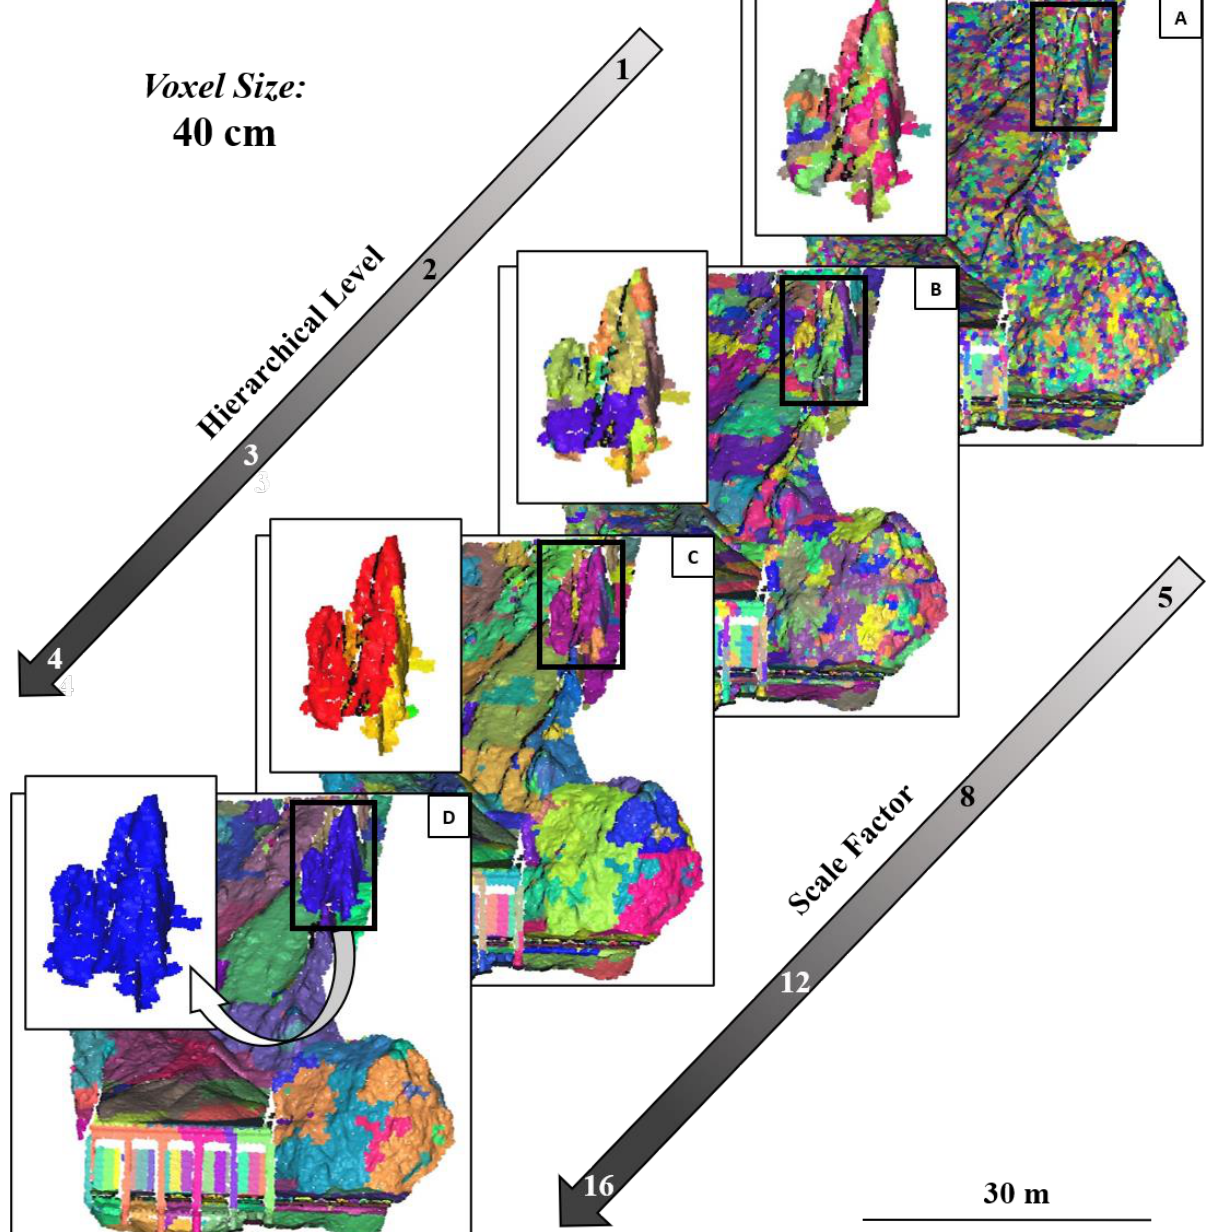
Figure 6. Hierarchical network built by means of FNEA. Four levels were selected from A to D representing scale factors 5, 8, 12, and 16, respectively. Relationships between each level’s object and their sub-objects are demonstrated in the zoomed